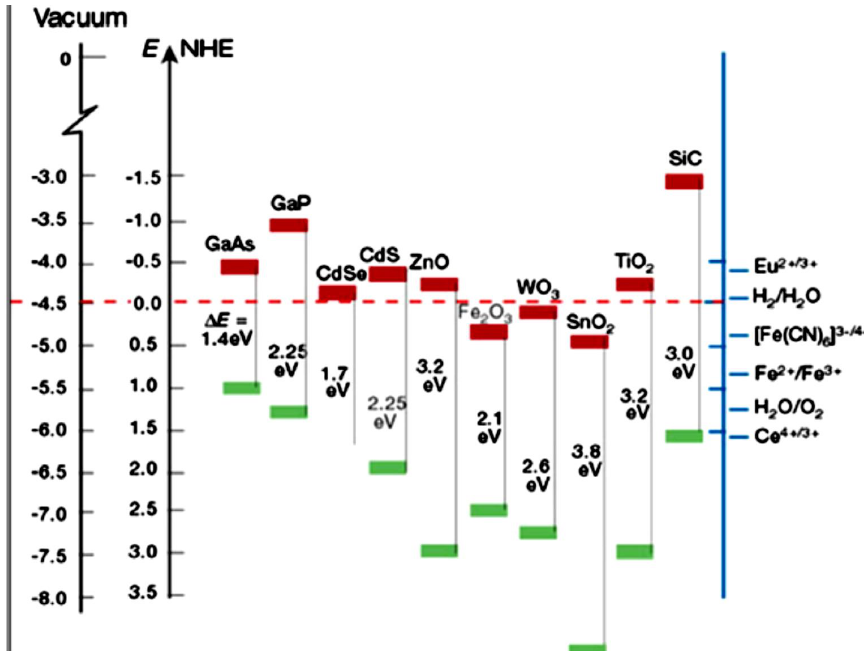
Figure 3. The band gap positions for various photocatalysts (E indicates the electric potential, and NHE stands for normal hydrogen electrode potential) [39]. Nanomaterials 2019 , 9 , x FOR PEER REVIEW